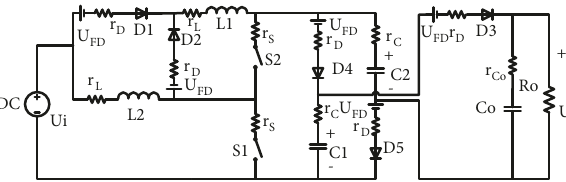
Figure 5: Nonideal equivalent circuit of the DS-HS converter.